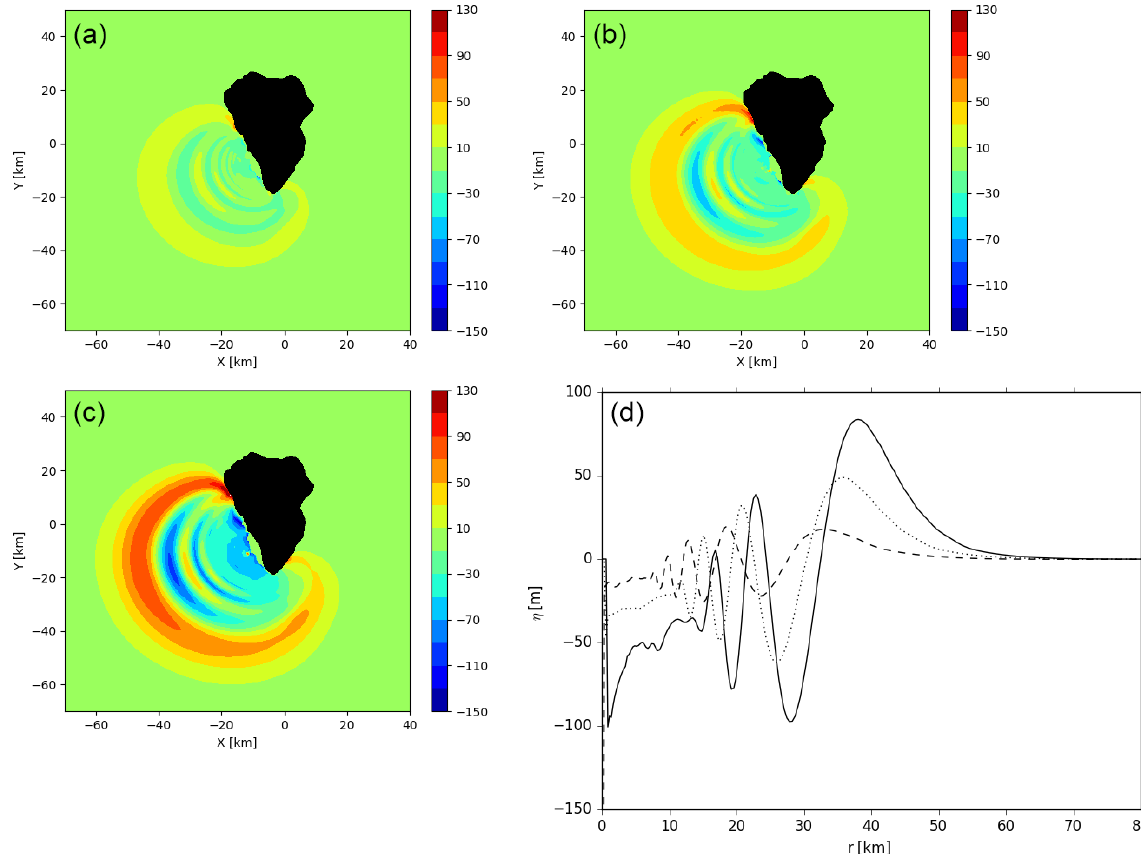
Figure 13. THETIS 3D computations for 20km 3 (a) , 40km 3 (b) and 80km 3 (c) slide scenarios at t = 5min. (d) Free surface elevations along section A–B of the left frame of Fig. 12. Slide viscosity is 2 × 10 7 Pas. Slide volume of 80km 3 : continuous line; slide volume of 40km 3 : dotted line; slide volume of 20km 3 : dashed line.